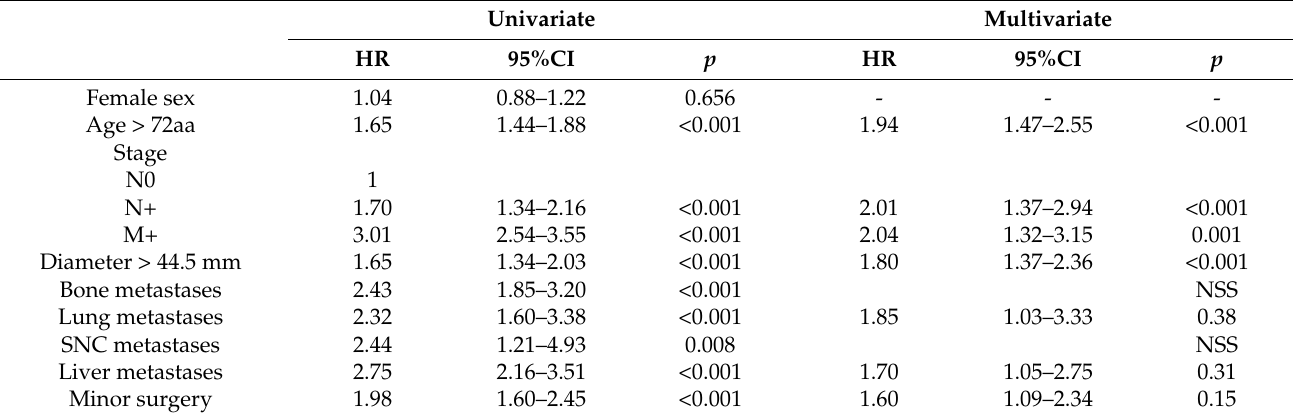
Table 2. Univariate and multivariate Cox proportional hazard models for the risk of death. Significant p -values are highlighted in bold. Univariate Multivariate HR 95%CI p HR